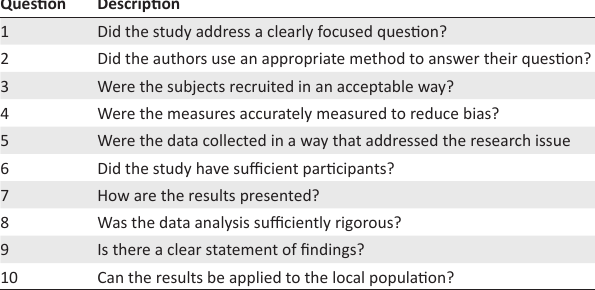
TABLE 1-A2: Quality assessment tool for cross-sectional